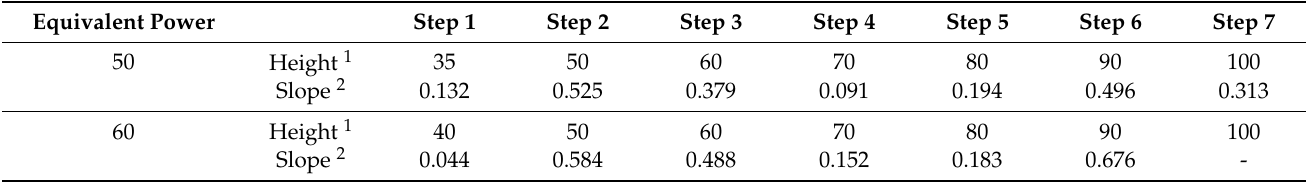
Table 3. Calibration slopes for the equivalent powers from 50% to